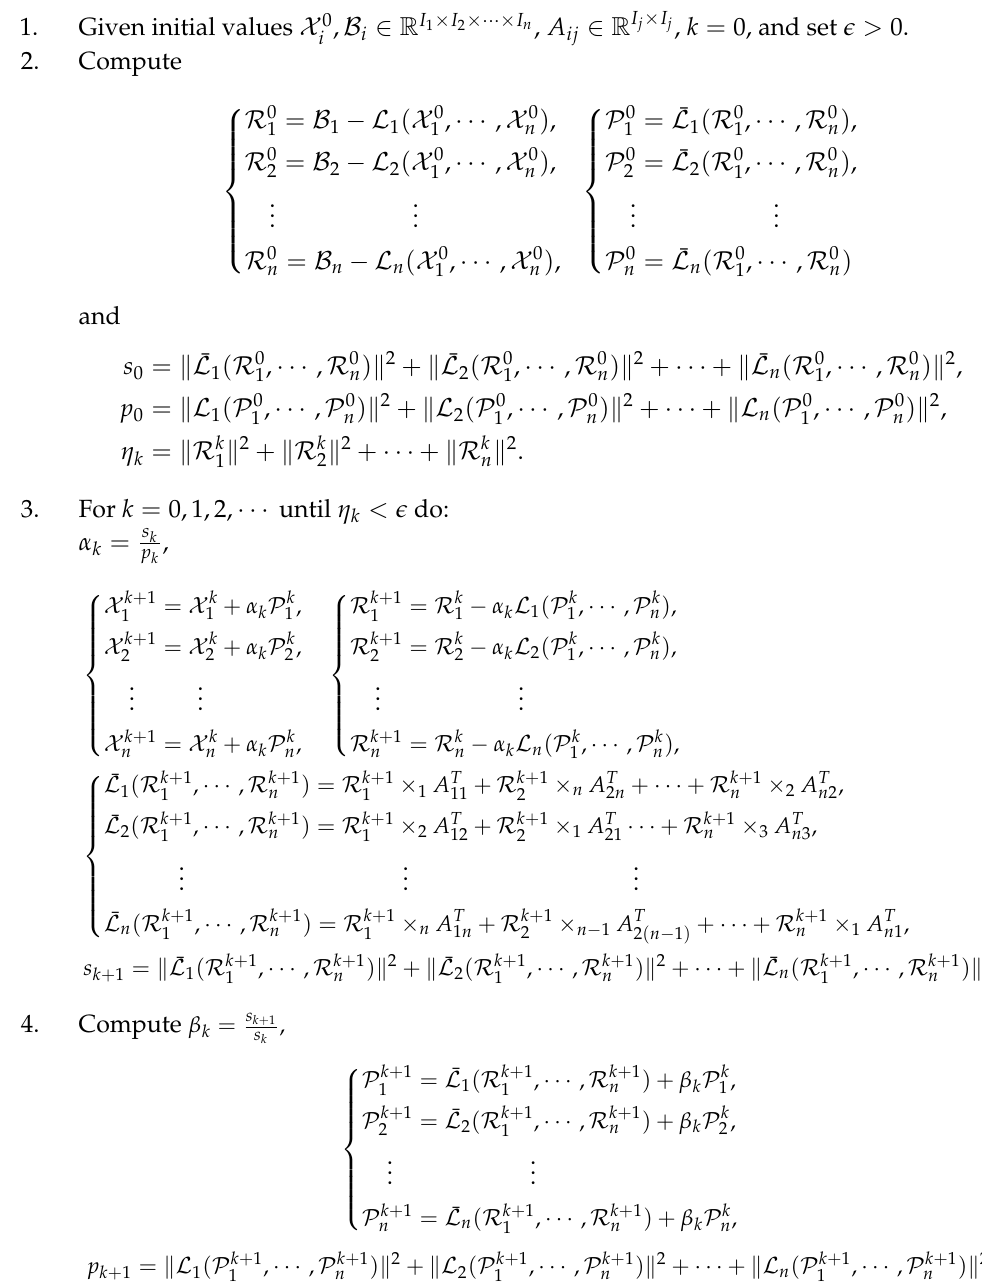
Algorithm 1 A modified conjugate residual method for solving Equation